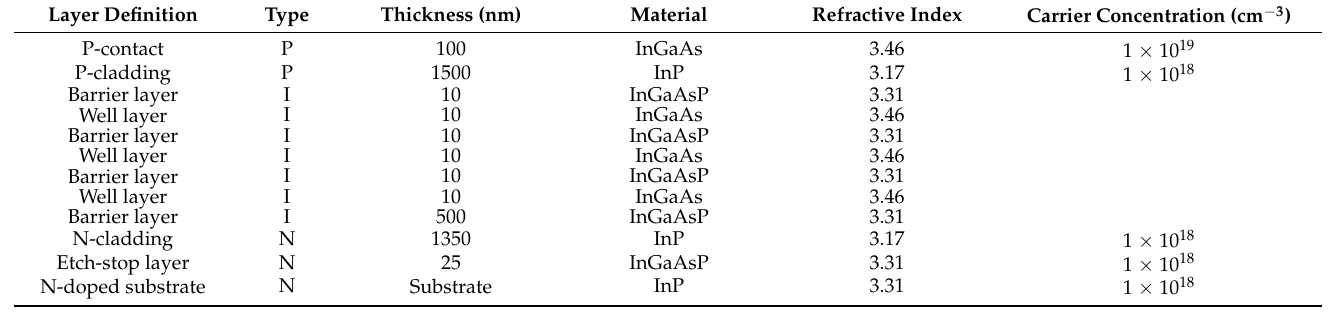
Table 1. Detailed parameters for each semiconductor layer of the MQW waveguide amplifier (the bandgap of InGaAsP is at 1.25 µ m).